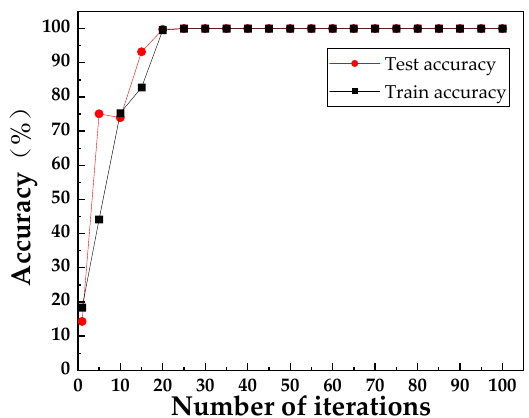
Figure 8. Fault diagnosis accuracy of CEEMDANICA-TDCNN.